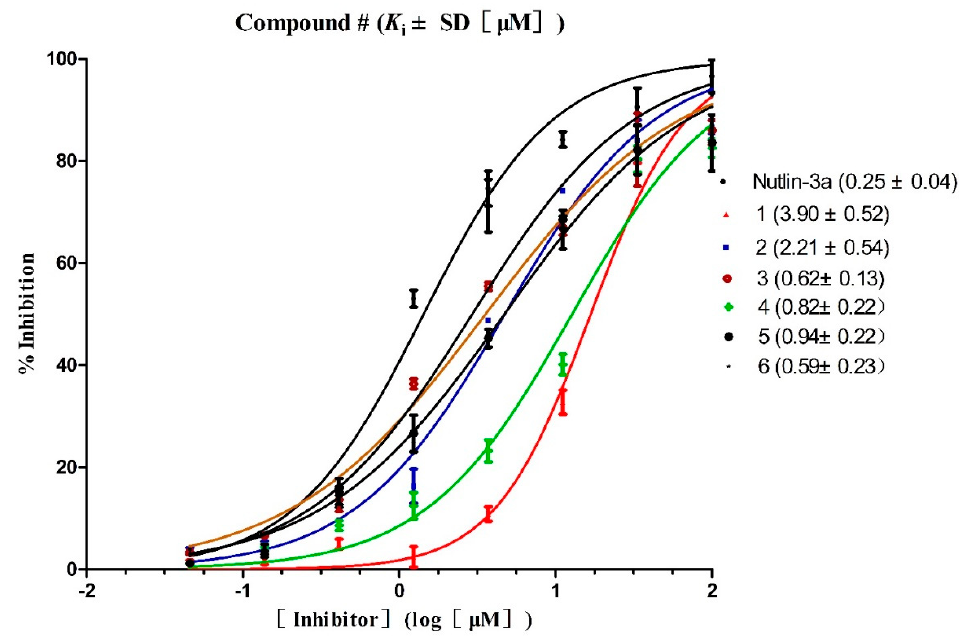
Figure 7. Competitive binding curves of small-molecule inhibitors to MDM2/p53 PPI as determined using a fluorescence-polarization-based binding assay.